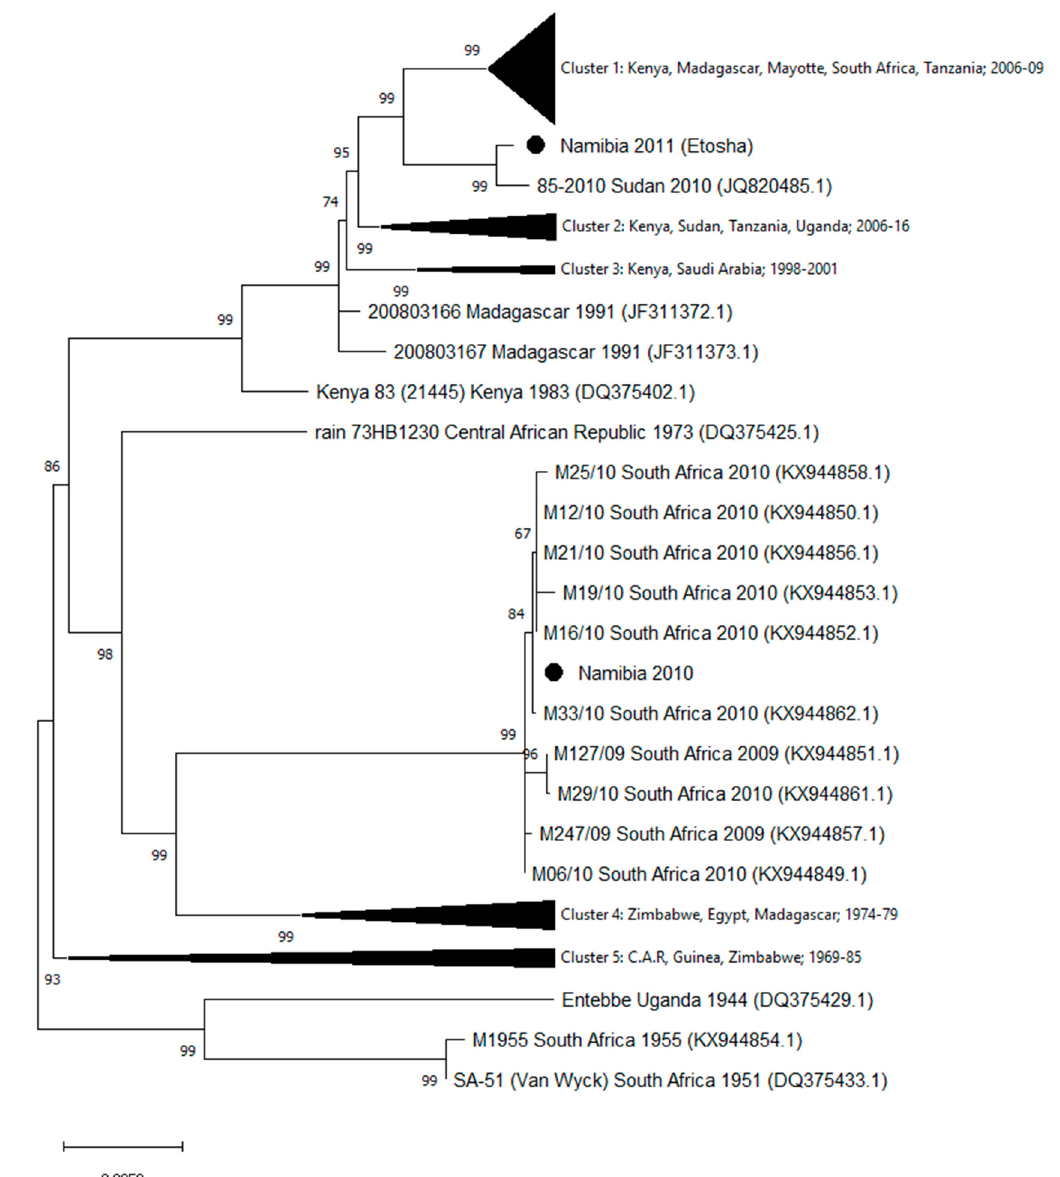
Figure 1. Phylogenetic tree of Rift Valley fever virus (RVFV) generated by the maximum likelihood method with bootstrap (500 replicates) based on 6404 nucleotides of the L genomic segment of RVFV. Analysis involved 94 nucleotide sequences available in GenBank. Compressed Cluster 1 includes 43 sequences from Kenya, Madagascar, Mayotte, South Africa, and Tanzania, collected in the period 2006–2009; Cluster 2: ten sequences from Kenya, Sudan, Tanzania, and Uganda collected in 2006–2016; Cluster 3: three sequences from Kenya and Saudi Arabia, collected in the period 1998–2001; Cluster 4: eleven sequences from Zimbabwe, Egypt, and Madagascar, collected in 1974–1979; Cluster 5: seven sequences from C.A.R, Guinea, and Zimbabwe, collected in 1969–1985. The strain names and accession numbers of the sequences included in the compressed clusters are listed in Table S2.